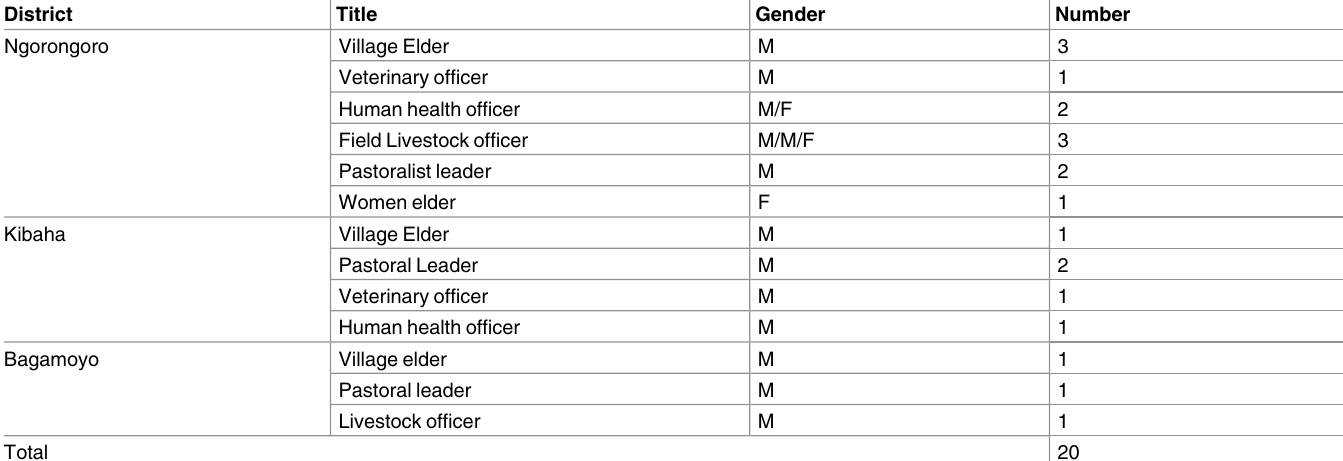
Table 4. Key informant interviews.